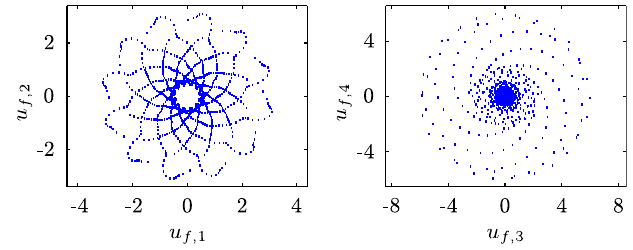
FIG. 5. Beam centroid trace in the normalized phase space is the first column of the ~ U f (beam turn from 930 to 2100). u f; 1 matrix, determined from the SVD of turn-by-turn measurements (see Figs. 2 and 3) using the mode untangling technique described in Sec.